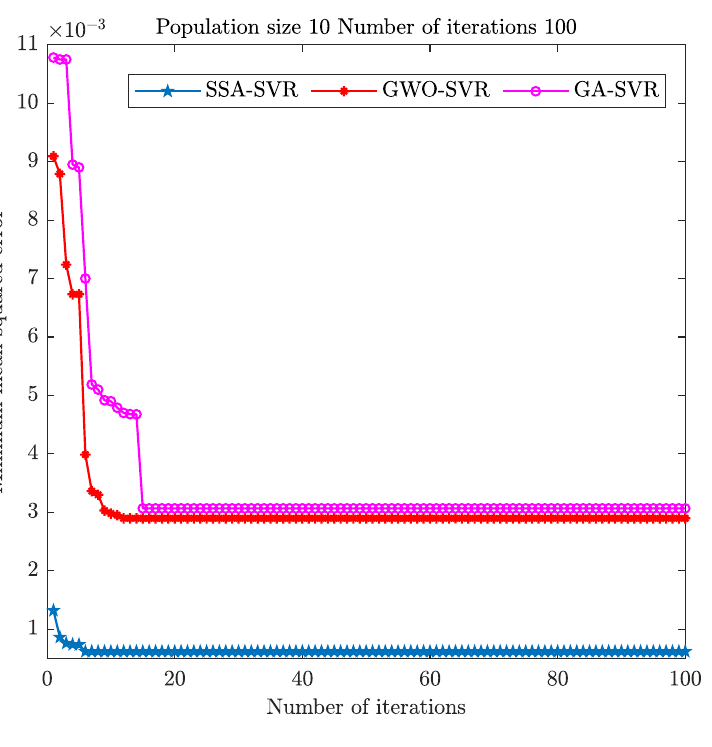
Figure 7. The mean square error of the three optimization